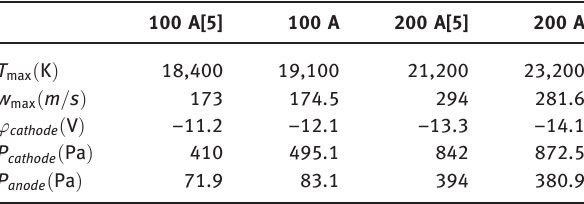
Table 3: Comparison of the essential